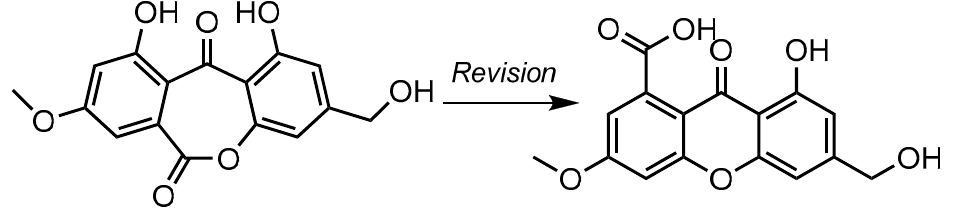
Figure 2. Structure revision of an oxepinedione-containing anthraquinone to a carboxylic acid-containing scaffold: example of wentiquinone C.